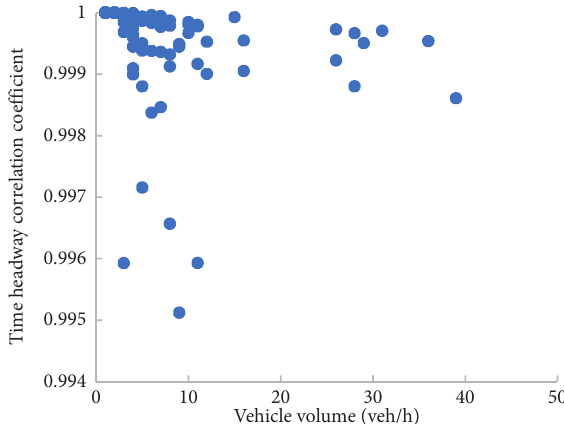
Figure 7: Time headway correlation coefficient vs. vehicle volume.